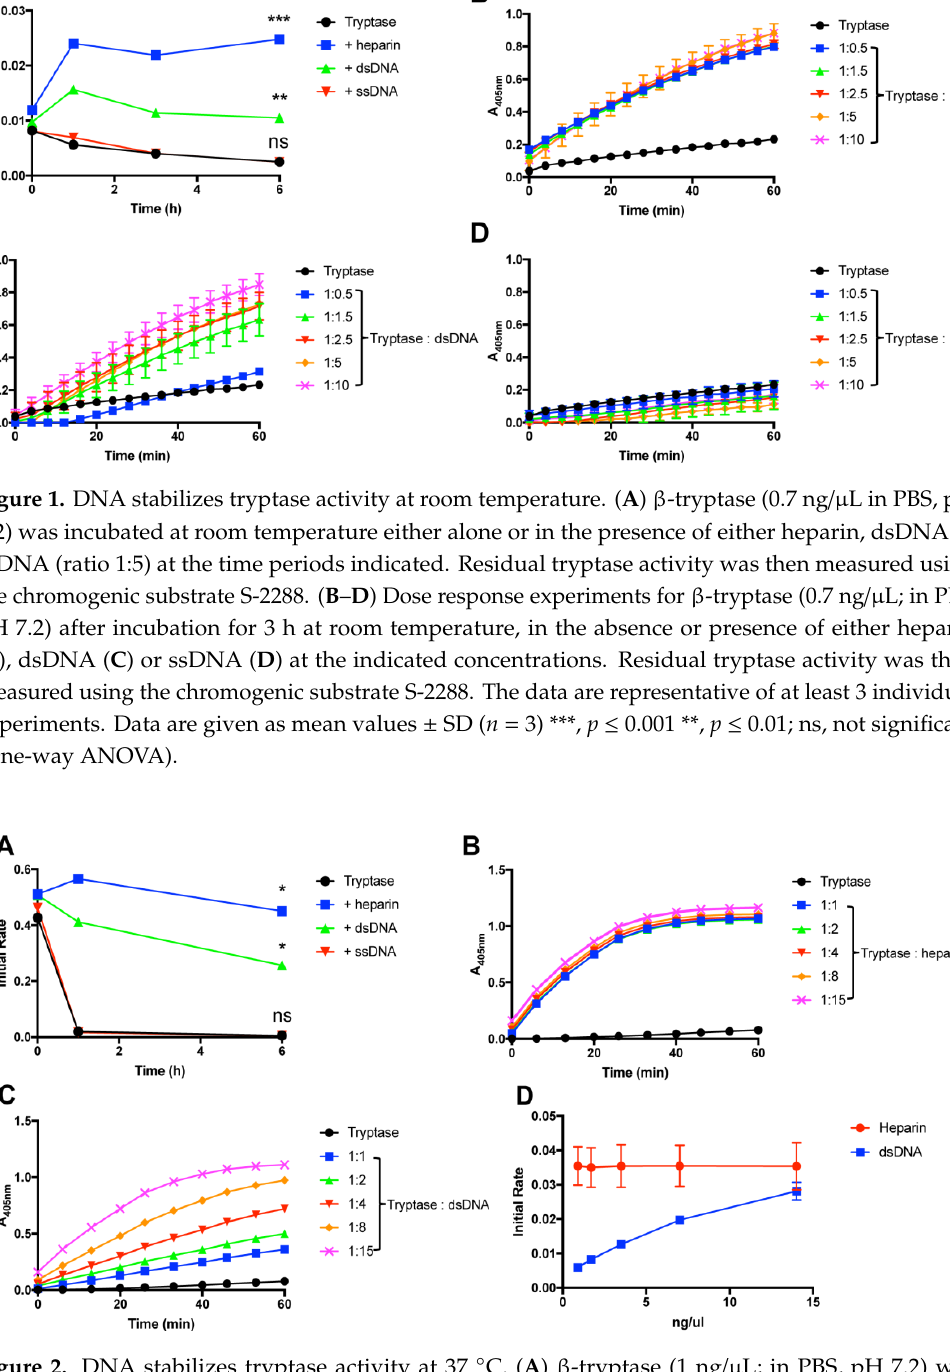
Figure 2. DNA stabilizes tryptase activity at 37°C. ( A ) β -tryptase (1 ng/µL; in PBS, pH 7.2) was incubated at 37 °C either alone or in the presence of either heparin, dsDNA or ssDNA (ratio 1:5) at the time periods indicated. Residual tryptase activity was then measured using the chromogenic substrate S-2288. ( B, C ) Dose response experiments were performed where tryptase (1 ng/µL) was incubated for 3 h at 37 °C, in the absence or presence of either heparin, dsDNA or ssDNA at the indicated concentrations. ( D ) Initial reaction velocities from B – C are displayed. Residual tryptase activity was measured using the chromogenic substrate S-2288. The data are representative of at least 3 individual experiments. Data are given as mean values ± SD ( n = 3) *, p ≤ 0.01; ns, not significant (One-way ANOVA).